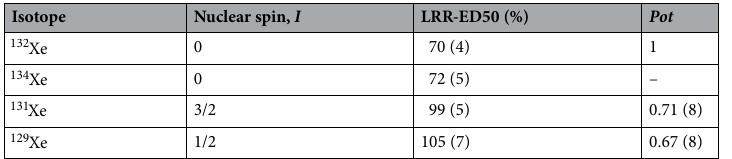
132 134 131 129 Xe, Xe, Xe, and